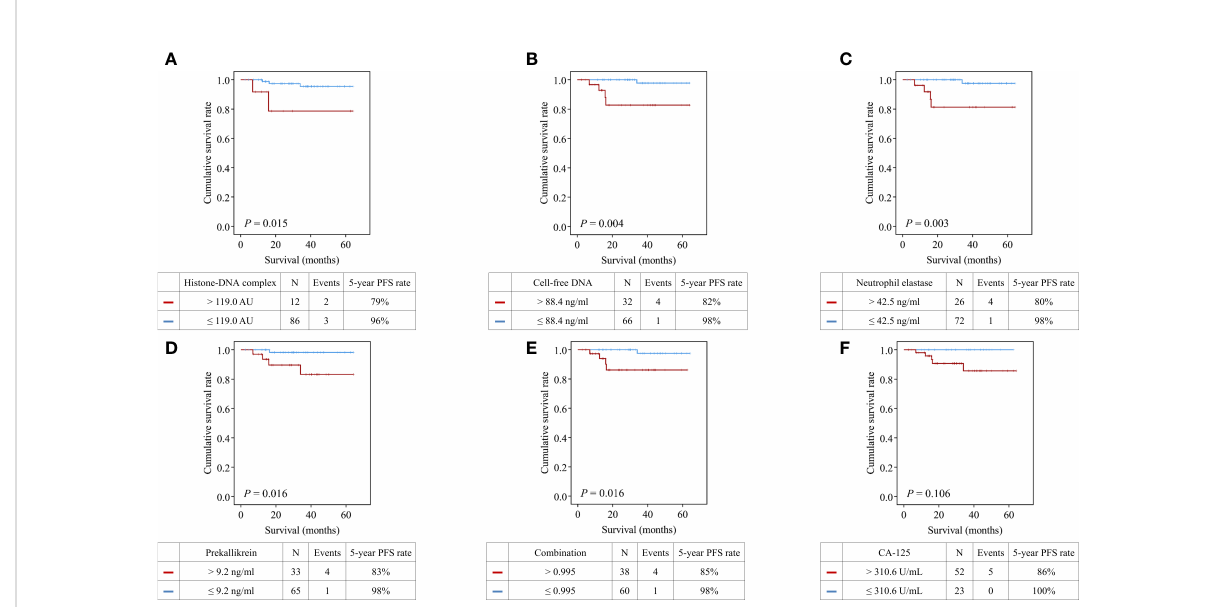
FIGURE 4 Comparisons of progression-free survival between patients with high and low levels of the markers. (A) Histone − DNA complex; (B) Cell-free DNA; (C) Neutrophil elastase; (D) Prekallikrein; (E) Logistic regression-based model of the four markers; (F) CA-125.